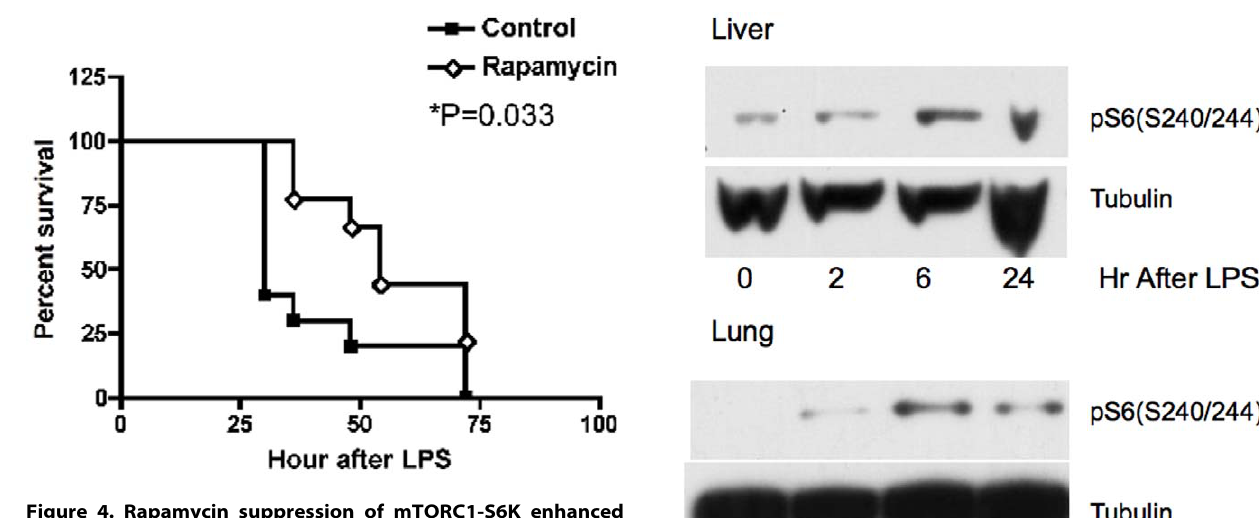
Figure 4. Rapamycin suppression of mTORC1-S6K enhanced early survival of endotoxemic mice. Kaplan-Meier curves of LPS- challenged mice treated with vehicle control (N=10) or rapamycin (N=9) are shown here. Rapamycin-treated mice had significantly better survival compared to vehicle-treated (P=0.033, logrank test). However, all mice had died by 72 hr after LPS challenge.